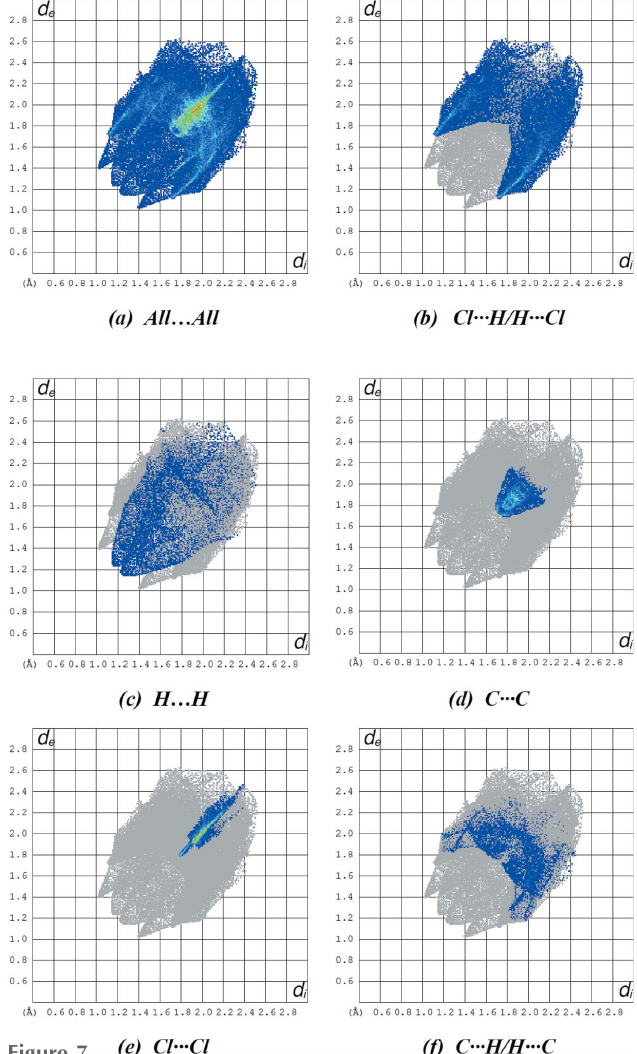
Figure 7 The full two-dimensional fingerprint plot for the title compound and those delineated into ( b ) Cl (cid:2)(cid:2)(cid:2) H/H (cid:2)(cid:2)(cid:2) Cl (35.1%), ( c ) H (cid:2)(cid:2)(cid:2) H (10.6%), ( d ) C (cid:2)(cid:2)(cid:2) C (9.7%), ( e ) Cl (cid:2)(cid:2)(cid:2) Cl (9.4%) and ( f ) C (cid:2)(cid:2)(cid:2) H/H (cid:2)(cid:2)(cid:2) C (9.2%) inter-